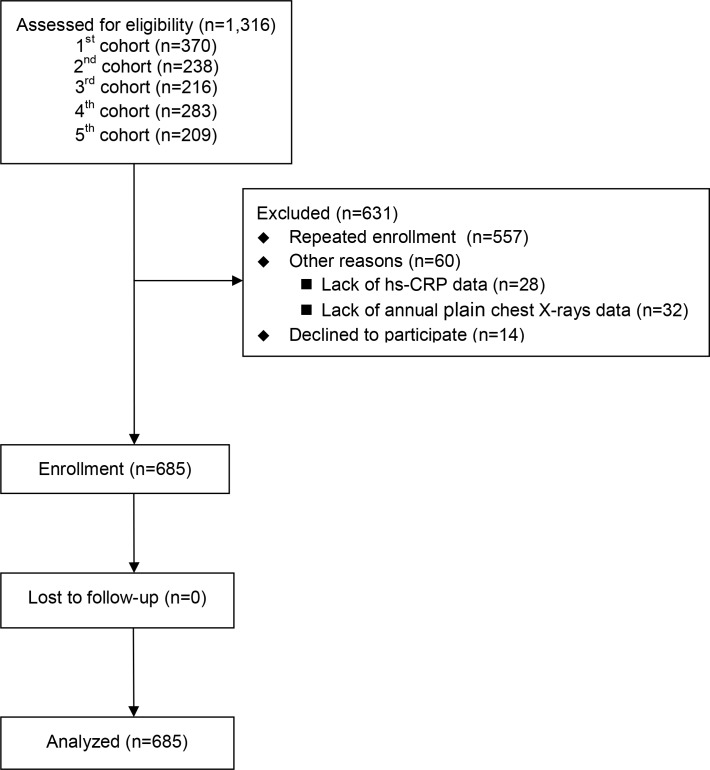
Study flow diagram.